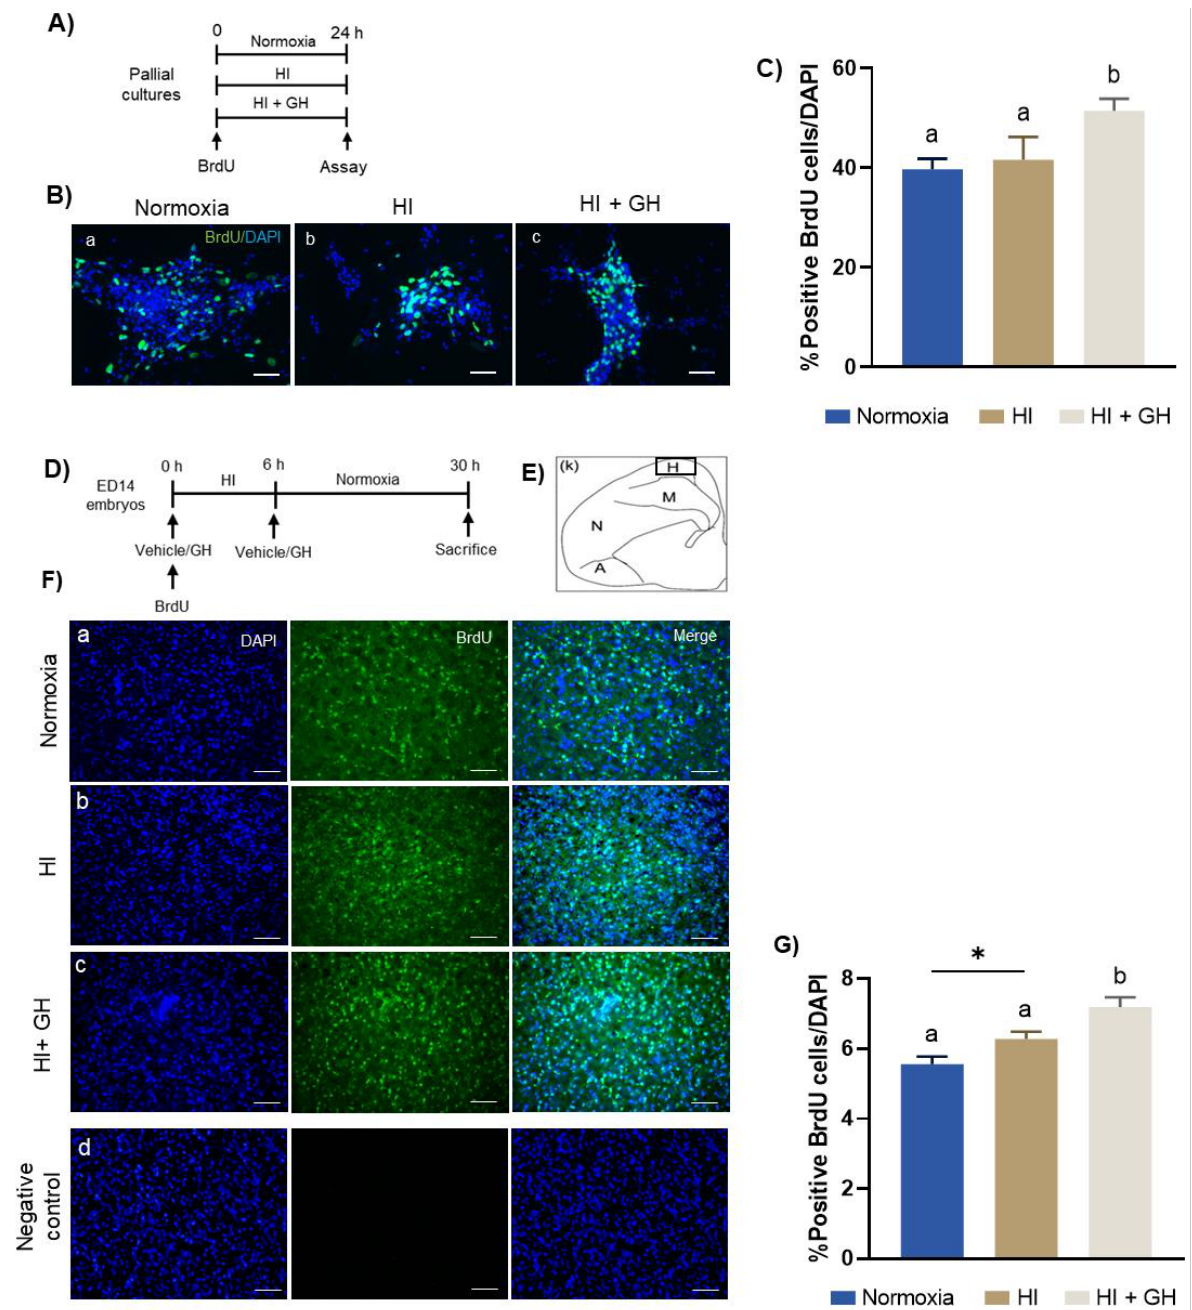
Figure 4. Growth hormone stimulates cell proliferation, both in vitro and in vivo, in embryonic chicken pallium exposed to a hypoxic–ischemic (HI) injury. ( A ) Schematic representation of time course and treatment protocol for the in vitro experiment. ( B ) Representative images of pallial neurons stained with BrdU (green) and DAPI (blue) in each experimental condition: ( a ) normoxia, ( b ) HI, ( c ) HI + 10 nM GH. Scale bar: 50 µm. ( C ) Relative proportion (%) of positive BrdU cells, expressed in relation to total DAPI labeled cells under each experimental condition. Bars represent mean ± SEM (3 independent experiments in duplicate; n = 6 cultures per group). Groups with different let- ters are significantly different by one-way ANOVA with Tukey’s post hoc test ( p < 0.05). ( D ) Sche- matic representation of time course and treatment protocol for the in vivo experiment. ( E ) Repre- sentative drawing of a coronal section of the embryonic chick brain showing the location of the hyperpallium ( H ) region. ( F ) Representative immunofluorescence images showing effects of the treatments upon BrdU+ cells in the hyperpallium of the chick embryos exposed to: ( a ) normoxia, ( b )